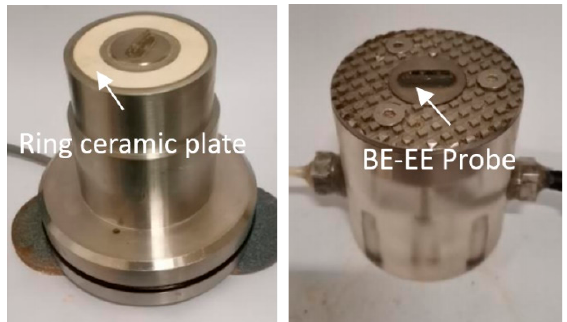
Figure 1. Photos of the reconstructed RC pedestal and top cap.